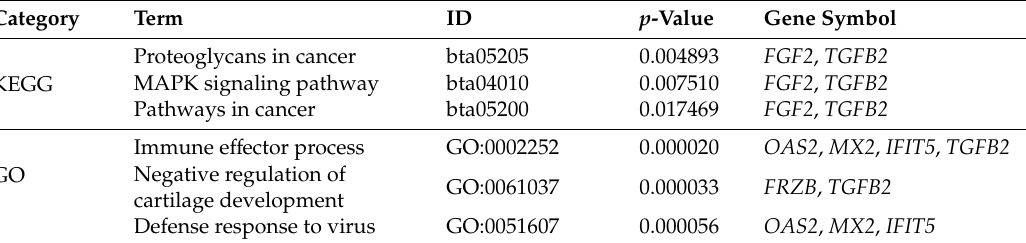
Table 2. GO terms and KEGG enrichment pathways (Top 3) for hub genes.